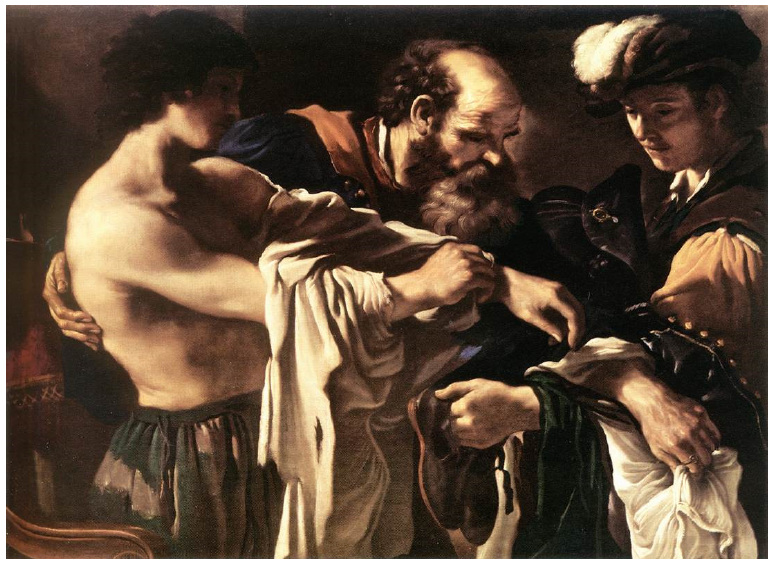
Figure 6. Guercino, Return of the Prodigal Son , 1619, Kunsthistorisches Museum, Vienna. Photo: Wikiart, Public Domain.